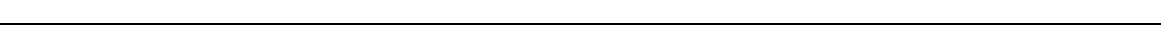
Fig. 1 Genetic landscapes of TCL models identify targetable vulnerabilities. a Mutational characteristics of the most recurrently altered genes in patients, PDX models and cell lines of different subtypes of T- and NK-cell lymphomas. Highlighted in red is the frequency of recurrent mutations in different subtypes of T- and NK-cell lymphomas, based on published sequencing studies (Supplementary Table 3) with n indicating the number of cases included. b GISTIC summary plots of the signi fi cant copy number gains (left panel, red) and losses (right panel, blue) in 20 T-cell lymphoma cell lines. Y-axis: chromosomal position, X -axis: false-discovery rate (FDR) q values. c A subset of selected fusions in PDX models and cell lines, identi fi ed by RNA-seq. d Immunoblotting in ALCL cell lines for the indicated targets. Wild-type JAK2 is approximately 130 kDa and PCM-JAK2 is approximately 260 kDa. e Copy number variants of JAK1 and JAK2 corresponding to d . f IC50 values for ruxolitinib corresponding to d . g Work fl ow of the ruxolitinib in vivo trial. h Spleens were harvested from mice treated with vehicle or ruxolitinib. Spleen weight, in fi ltration of the spleens by hCD45/hCD2 + cells and AnnexinV/7-AAD staining of vehicle vs ruxolitinib treated mice. Statistics: Unpaired two-sided t -test, * p < 0.05. i Immunoblotting of MAC2A cells treated in vitro with DMSO or 1 μ M ruxolitinib for 24 h and DFTL-28776 treated in vivo with vehicle or ruxolitinib for 7 days. Bar graphs in f and i indicate mean values of at least two independent experiments with error bars indicating standard error of the